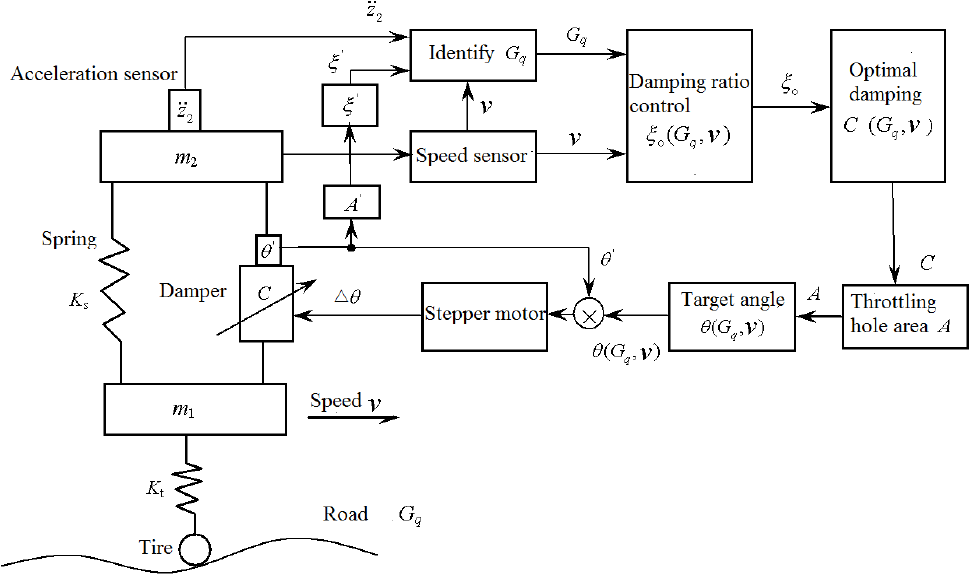
Figure 1. The new hydraulic semi-active suspension system.